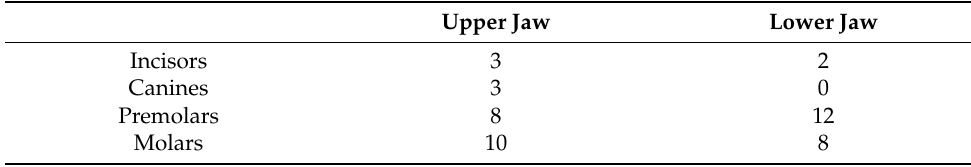
Figure 2. Kaplan–Meier survival curves for Group 1 and Group 2. “Censored” patients are patients where no debondings occurred within the study duration: the timepoints where they exit the study (after minimum 6 months follow-up) are marked by crosses on the survival curves.